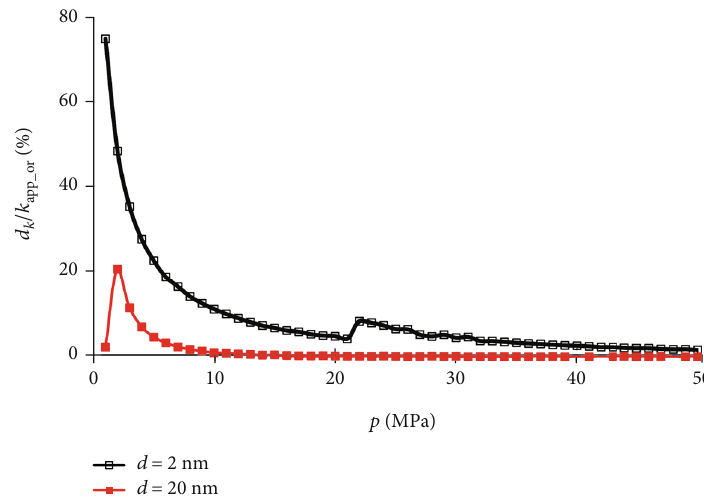
Figure 10: Curves of the ratio of change in the AGP to the AGP in the organic pore without considering the surface di ff usion e ff ect.